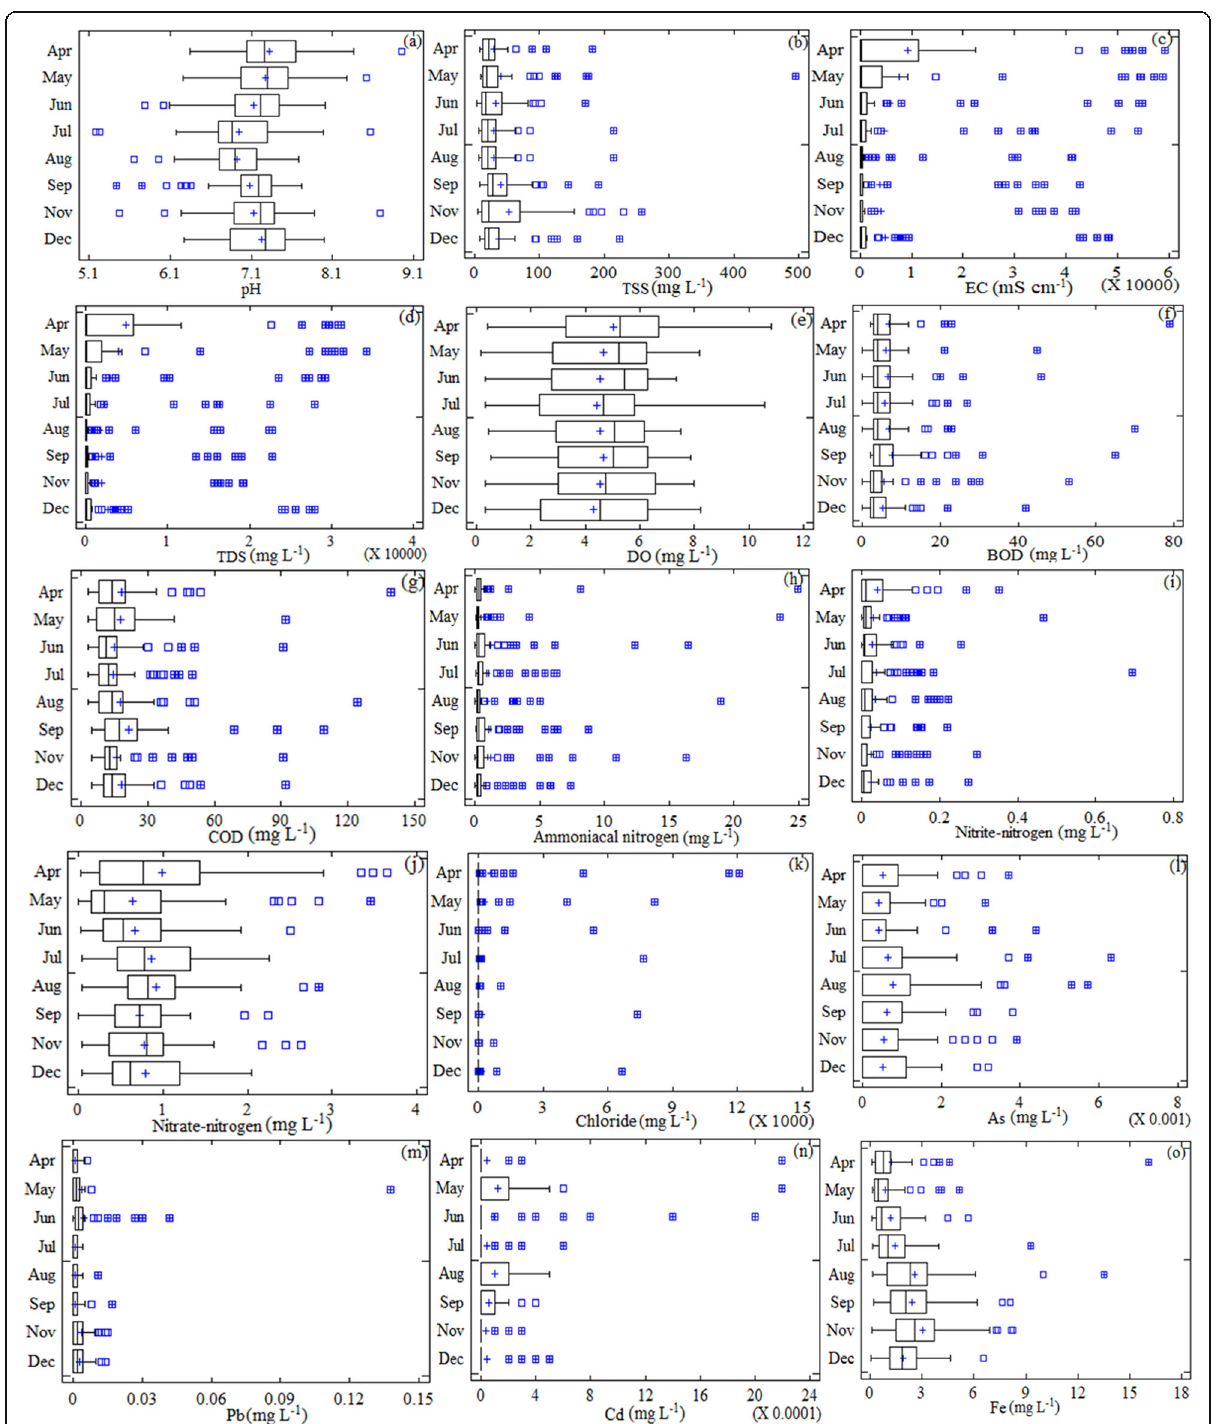
Fig. 2 Characteristics of surface water quality in southern Vietnam (Apr: April, Jun: June, Jul: July, Aug: August, Sep: September, Nov: November, Dec: